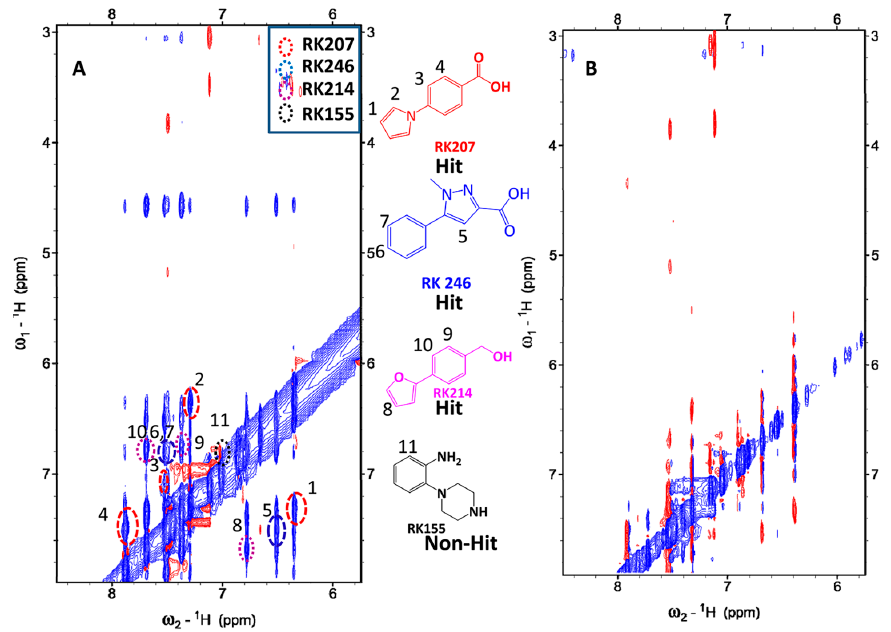
Figure 4. Comparison of the trNOE spectra between the mixture of 0.5mM each of RK207, RK246, RK214, and RK155 with: ( A ) 10 μ M of BrmGRX; ( B ) 10 μ M of hGRX1. The sign of cross-peaks from bound fragments are the same sign to that of the protein (the sign of the diagonal), thus confirming binding. Peaks corresponding to respective fragment protons are assigned with the same numbers. iLOEs present between fragments as a possible indication of synergistic binding that could be used in future fragment linking studies. Unassigned protons were not picked due to significant signal overlap or failing to appear in the spectrum. Red, blue and purple dotted oval circles on the left spectrum represent peaks for RK207, RK246, and RK214, respectively. As above these spectra are collected at 750 MHz with cold probe.